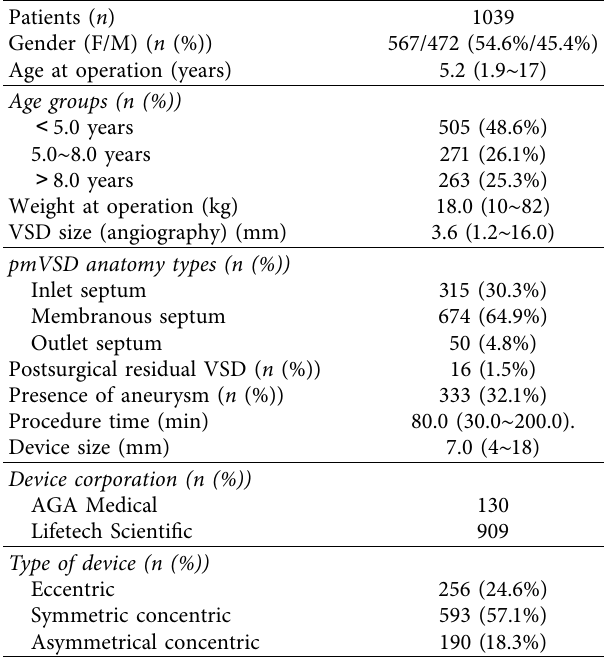
Table 1: Demographics and clinical data. Patients ( n )